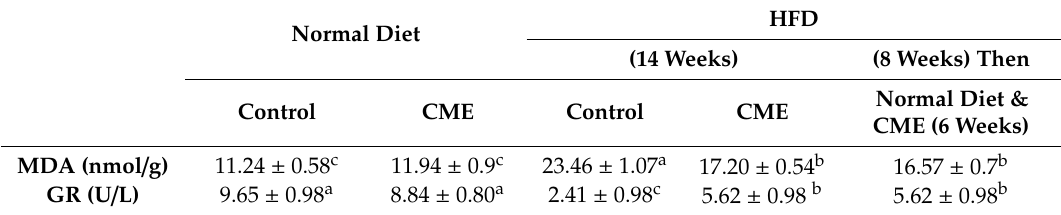
E ff ect of HFD and / or Commiphora myrrha resin extract on hepatic tissue content of malondialdehyde and activity of glutathione reductase after 14 weeks.